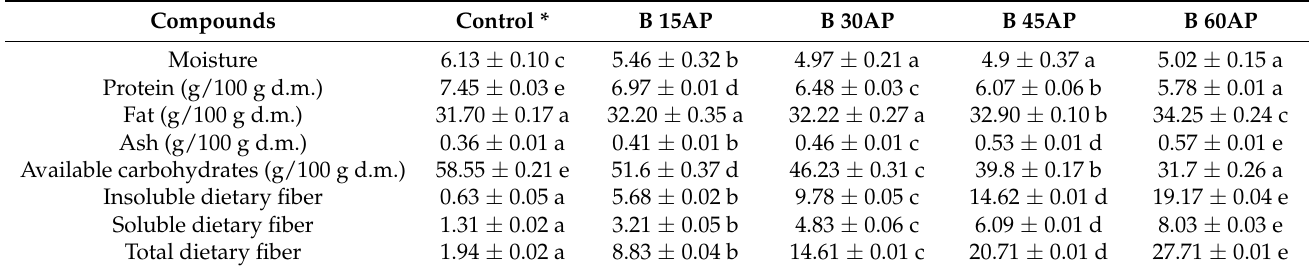
* Sample coding: see Table 1, different letters in the rows denote statistically different average values ( α = 0.05, n = 2). Gluten-free cookies with 15% and 30% apple pomace had a level of fat close to the control. Only the higher share of apple pomace, 45% and 60% contributed to the